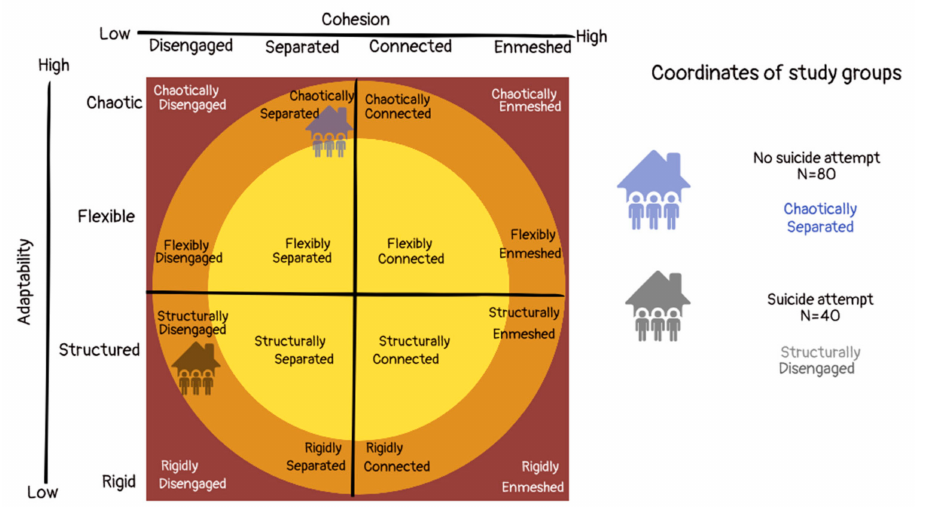
Figure 2. Coordinates of the study groups according to Olson’s circumplex model, showing the family types with the highest frequency found in our